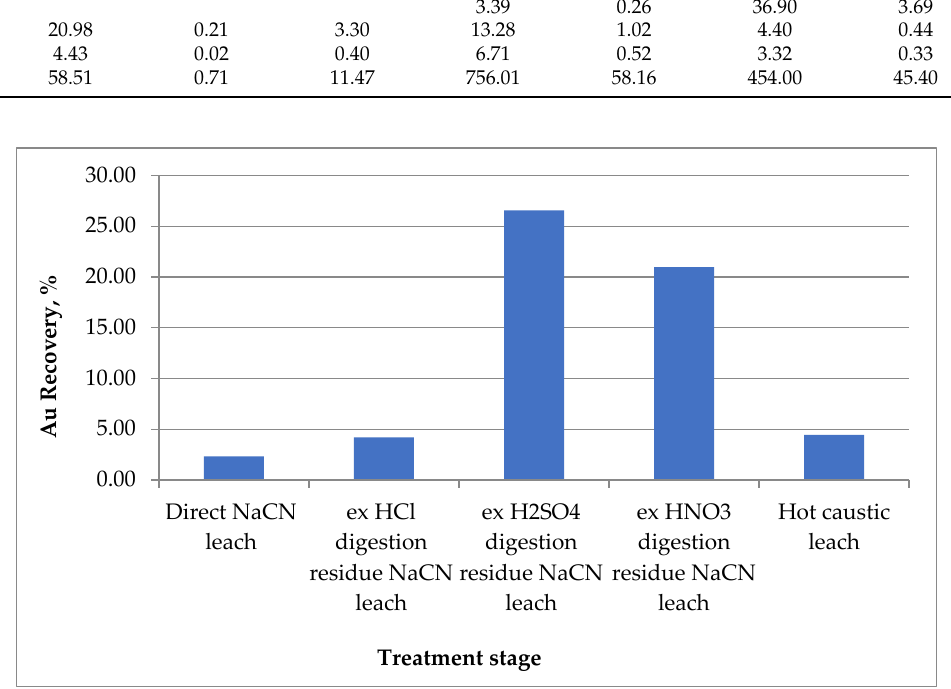
Figure 5. Recovery of gold after each acid pretreatment stage.